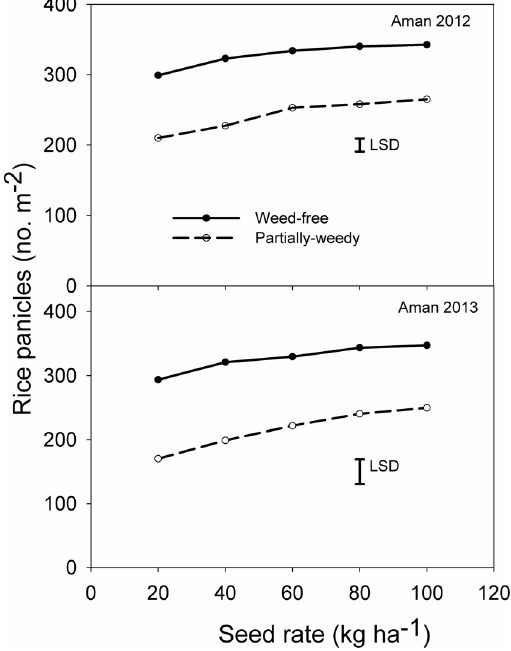
Figure 5. Effect of rice seeding rate and weed infestation level on rice panicle (number m 2 2 ) at crop harvest in 2012 and